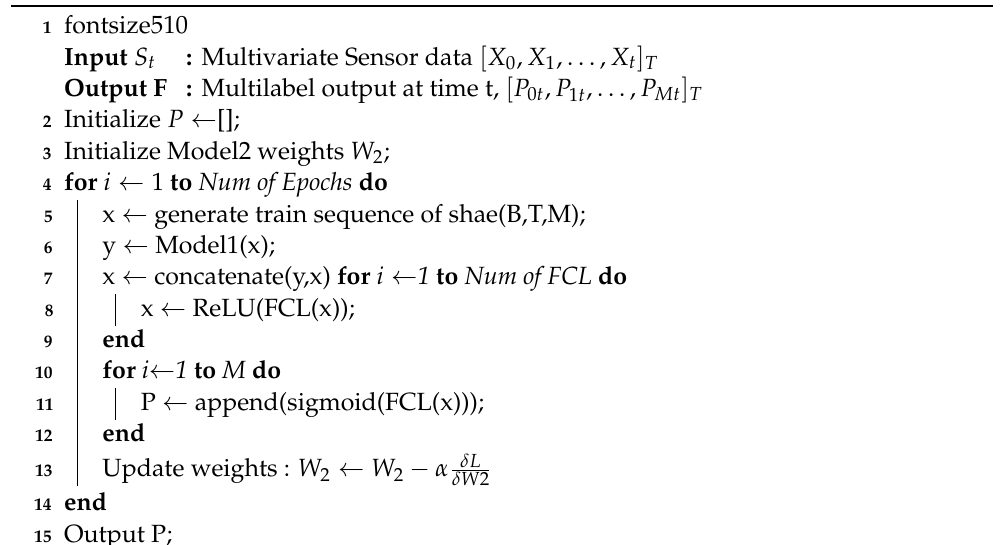
Algorithm 2: location detection module